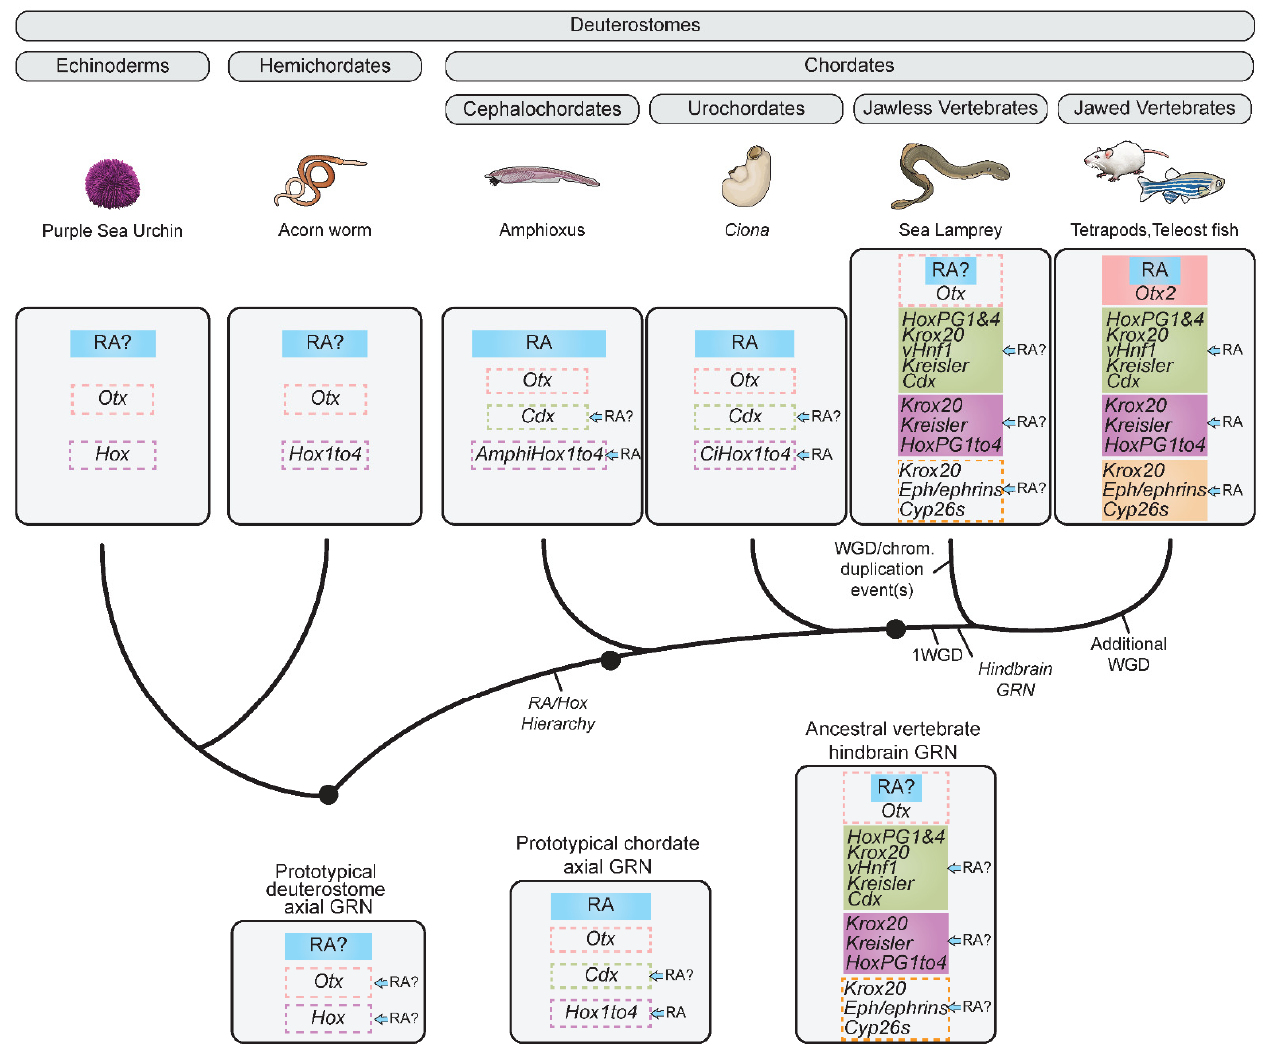
Figure 4. Origins and evolution of the hindbrain GRN. Schematic phylogenetic tree representing a model for the evolution of the vertebrate hindbrain GRN based on comparative evolutionary analyses of key components of the axial patterning GRN in deuterostomes, in relation to major events of genome rearrangement. Examples of patterning genes that display homologous expression domains with respect to vertebrates are depicted and considered to be part of a putative ancestral axial GRN (e.g., Cdx , Otx ). Color-coded dotted box are used to illustrate the putative evolutionary history of these conserved genes with respect to the module they belong to in the vertebrate hindbrain GRN (in accordance with Figure 3). Ancestral roles of RA in regulating aspects of the axial GRN, including Hox genes, (blue arrow) and presumptive roles of RA (blue arrow-question mark) are depicted. Important evolutionary events with respects to this GRN are indicated, such as the emergence of the Hox/RA hierarchy. Prototypical axial GRN models with respect to different evolutionary time points are summarized at the bottom. Jawed vertebrate gene names are based on mouse and zebrafish models. Ci, Ciona ; Amphi, Amphioxus. Cartoons of different model organisms are adapted from [34] .